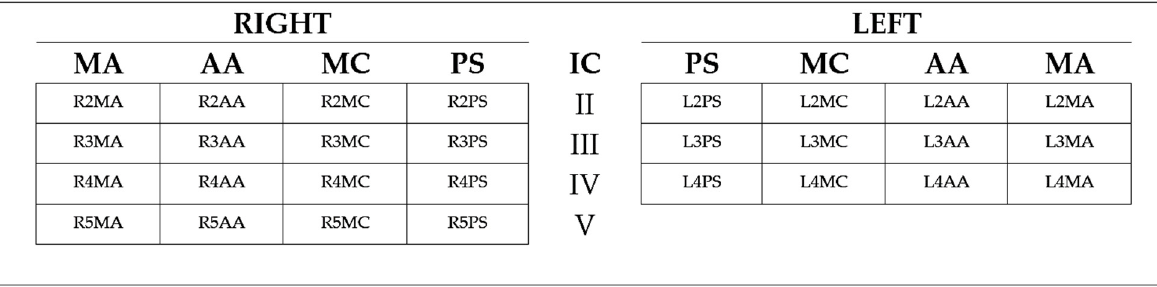
Figure 1. A map of chest site scans for BLS assessment. The figure shows the 28 chest sites scanned for the BLS calculation. The code of each site describes its space alignment: R: Right Chest; L: Left Chest; 1 to 5: the number of the intercostal space (IC); MA: Mid-Axillary Line; AA: Anterior-Axillary Line; MC: Mid-Clavicular Line; PS: Parasternal Line.